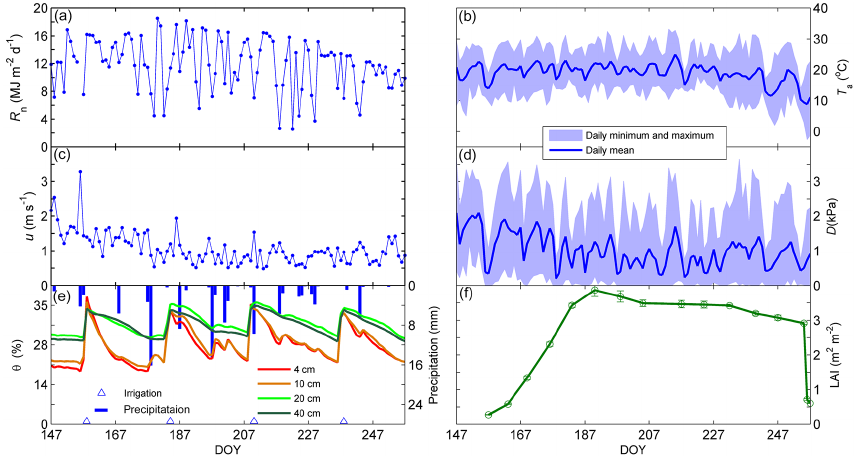
Figure 3. Seasonal variation in (a) R n (MJm − 2 day − 1 ) , (b) T a ( ◦ C), (c) D (kPa), (d) u (ms − 1 ) at the height of 3m, (e) precipitation and irrigation (mm), θ (m 3 m − 3 ) at 4, 10 20 and 40cm depth, and (f) LAI (m 2 m − 2 ) during the study period in the Daman Oasis.